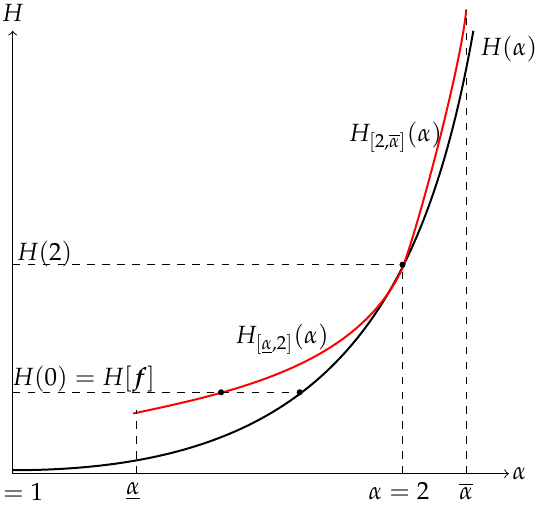
Figure 2. The geometric interpretation of the present method; H ( α ) ≡ H [ f + α ( f eq − f )] and H [ α ,2 ] ( α ) , H [ 2, α ] ( α ) are quadratic approximations of H ( α ) in the intervals [ α ,2 ] and [ 2, α ]